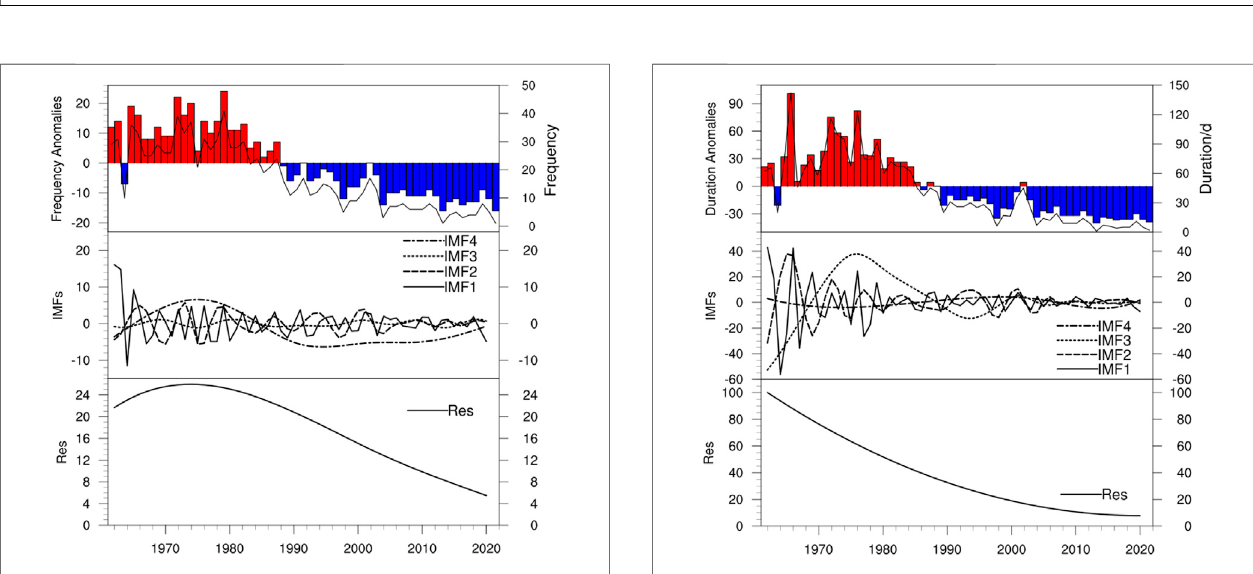
FIGURE 9 | Monthly probability of the maximum number of affected stations for (A) suspended-dust, (B) blowing sand, and (C) sand-dust storm processes.